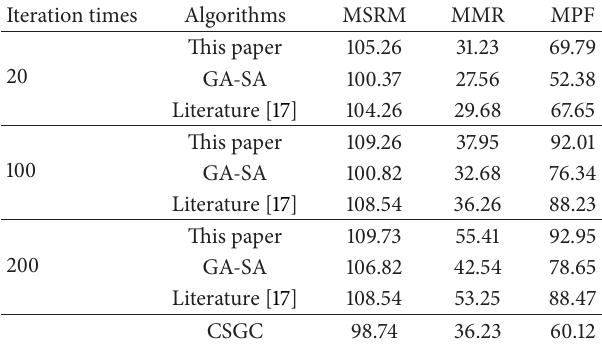
Table 2: Network benefits comparison with other algorithms ( 𝑀 = 𝑁 = 20 ).